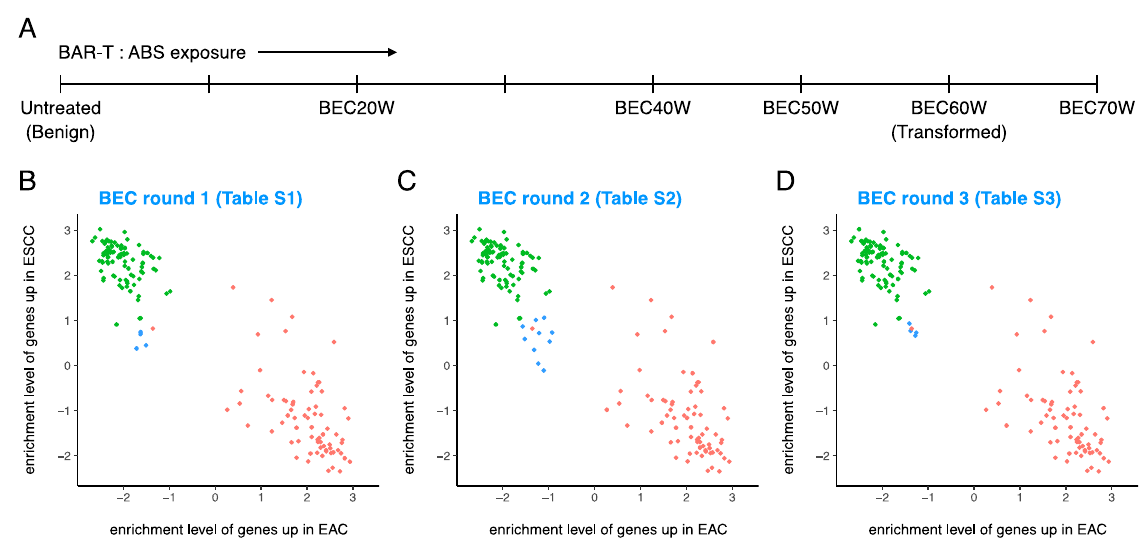
Figure 5. ABS exposure was not sufficient to induce EAC-like GEP in the BE cell line BAR-T and it remained ESCC-like even after malignant transformation. ( A ) Outline of the various time points at which BAR-T samples were collected from a previously established in vitro model of BE carcinogenesis. Several untreated BAR-T samples were also included in the analysis. ( B – D ) Enrichment levels of 100 EAC hi and 100 ESCC hi genes showed that BAR-T samples remain ESCC-like despite ABS exposure and do not become EAC-like even after malignant transformation. Red = EAC cases from TCGA, green = ESCC cases from TCGA, and blue = test samples (various types of samples from datasets other than TCGA). We sequenced 10 samples with various levels of ABS exposure obtained from the BEC model (4 malignantly transformed, 6 un ‐ transformed) and 8 ABS unexposed samples